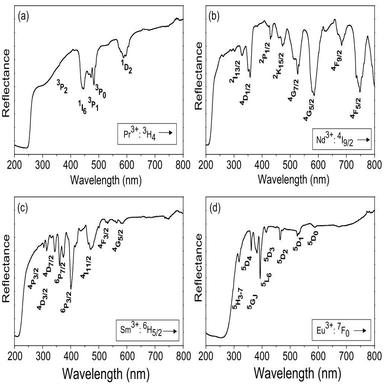
Diffuse reflectance spectra for the Ln2Ge2O7 materials in the range 200–800 nm, with the identification of the main intraconfigurational f-f transitions for the triclinic pyrogermanates: (a) Pr2Ge2O7; (b) Nd2Ge2O7; (c) Sm2Ge2O7; and (d) Eu2Ge2O7 samples.